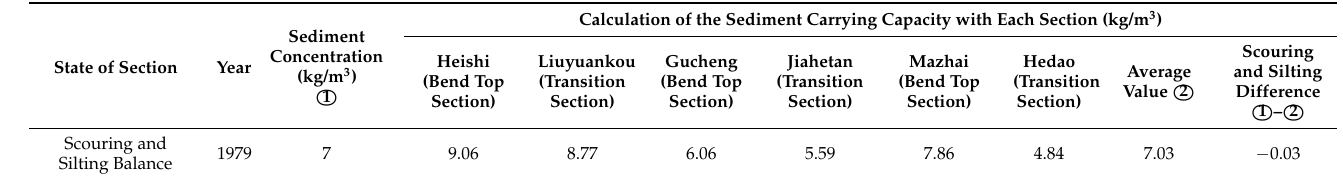
Table 8. Verification of scouring and silting state of each section before the construction project (800 m 3 /s).